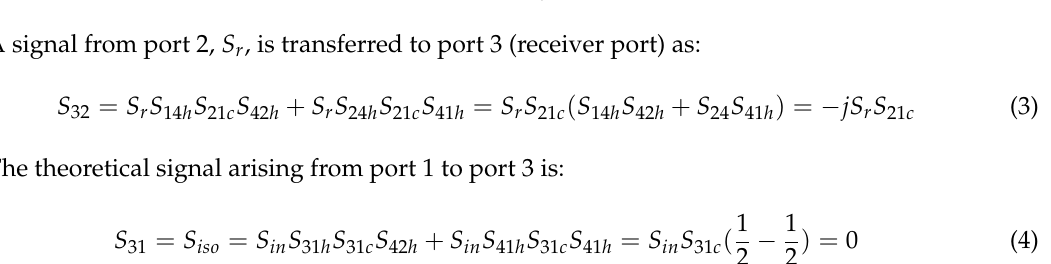
Figure 1. Generic anti-self-jam